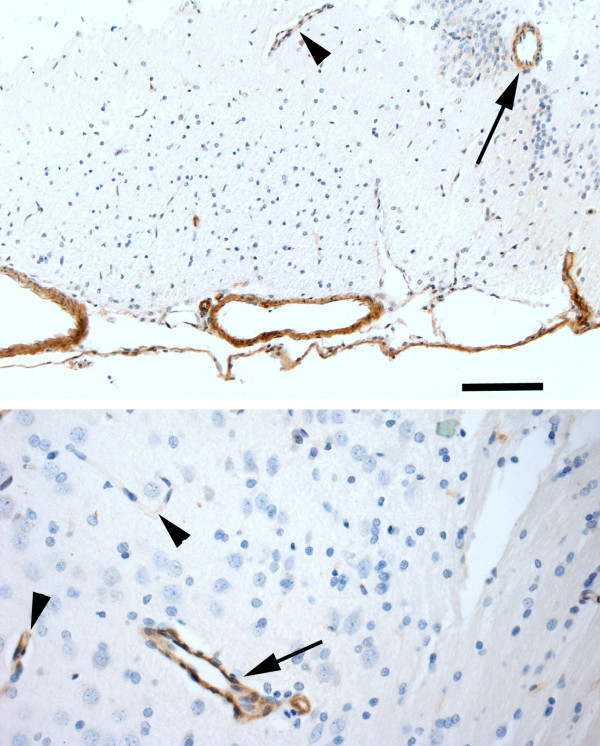
Caveolin-1 immunoreactivity in hydrocephalic rat brain. Upper panel shows base of control rat brain with strong immunoreactivity (brown) in surface arteries and arachnoid, as well as in penetrating arteries (arrow) and weaker immunoreactivity in veins (arrowhead). Bottom panel shows periventricular white matter (right) and deep cortex (left) of hydrocephalic rat brain 3 weeks after kaolin injection. Strong immunoreactivity is present in a cortical vein (arrow) and moderate to weak immunoreactivity in capillaries (arrowheads). Bar = 200 μm for top panel and 50 μm for bottom panel.